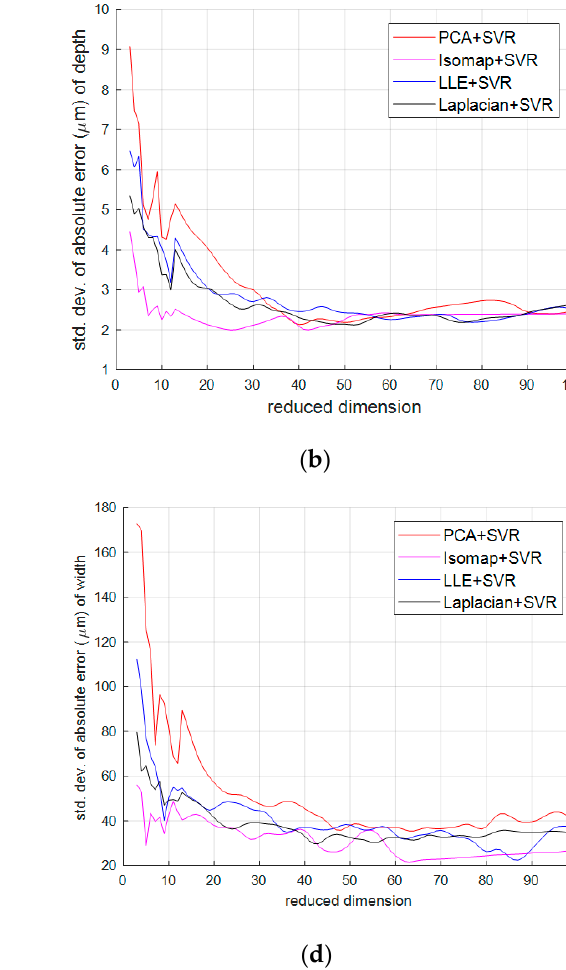
Figure 9. The 2D (top row) and 3D visualization (bottom row) of the width-labeled samples after dimensionality reduction.